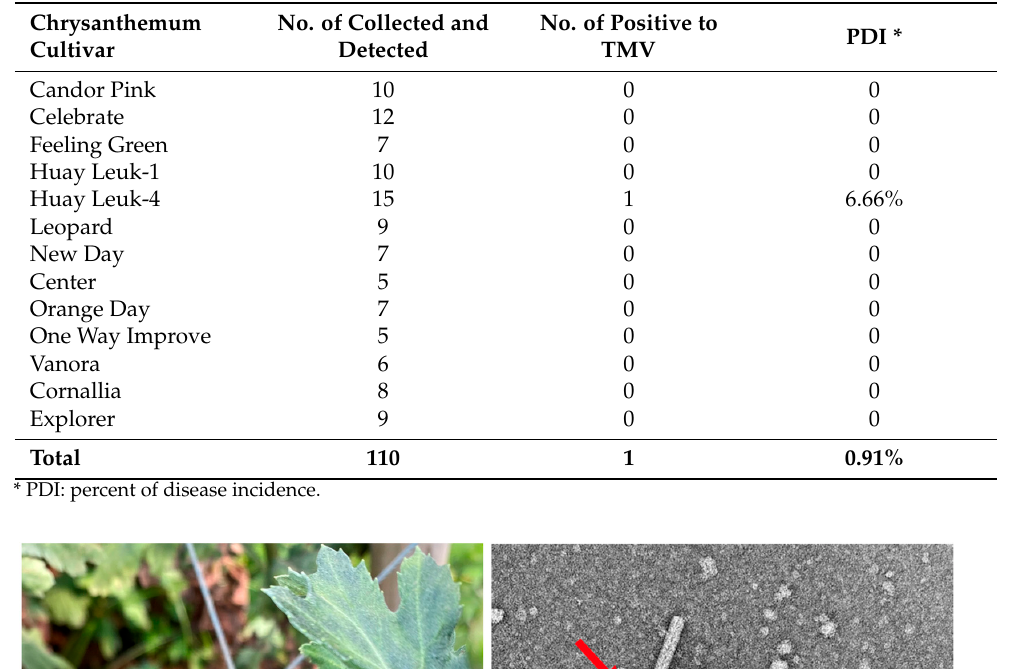
Table 1. RT-PCR detection of TMV from 110 samples of 13 chrysanthemum cultivars.